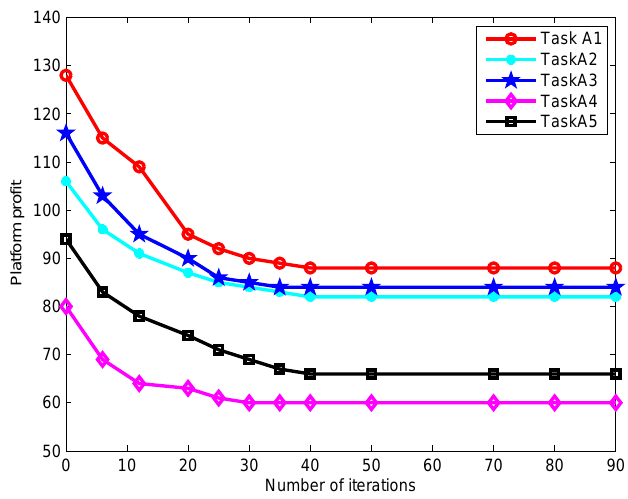
Figure 8. Changes in platform